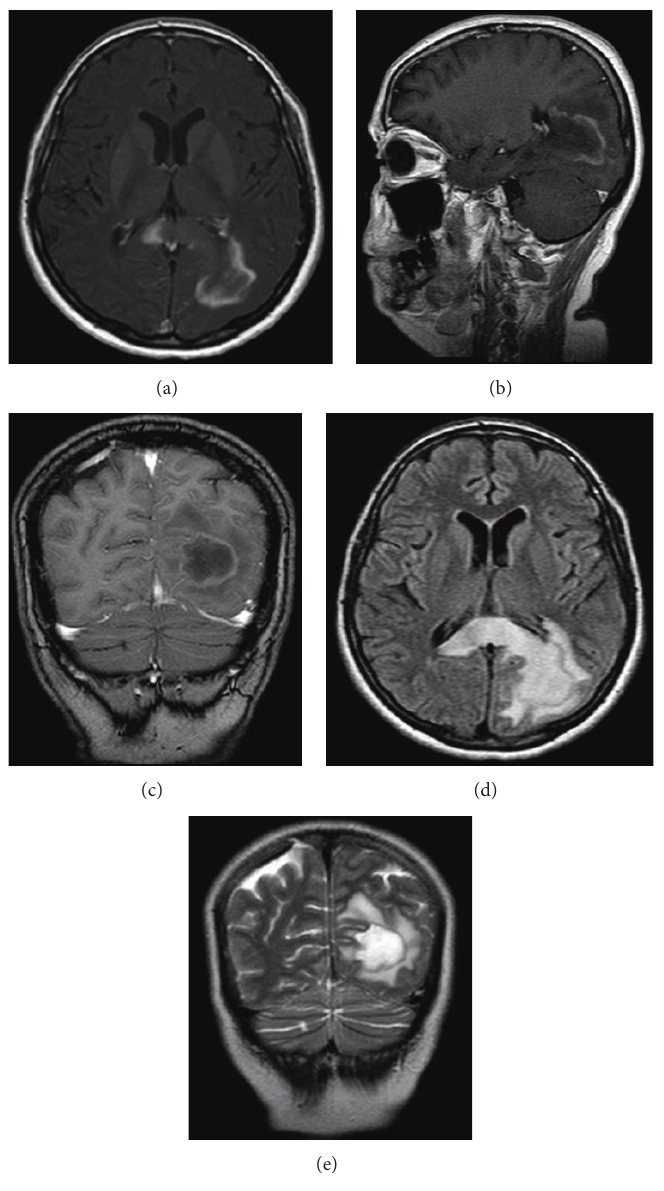
Figure 1: Cranial MRI showing (a) axial, (b) sagittal, and (c) coronal T1-weighted contrast enhanced views with open-ring enhancement of a hypointense lesion in the parietooccipital region with splenium corpus callosum involvement. (d) Axial FLAIR-weighted image showing hyperintenselesionintheparietooccipitalregionwithextensivespleniumcorpuscallosuminvolvement.(e)Rimlesions:coronalT2-weighted images showing a hypointensity margin relative to the hyperintensity of the lesion center and